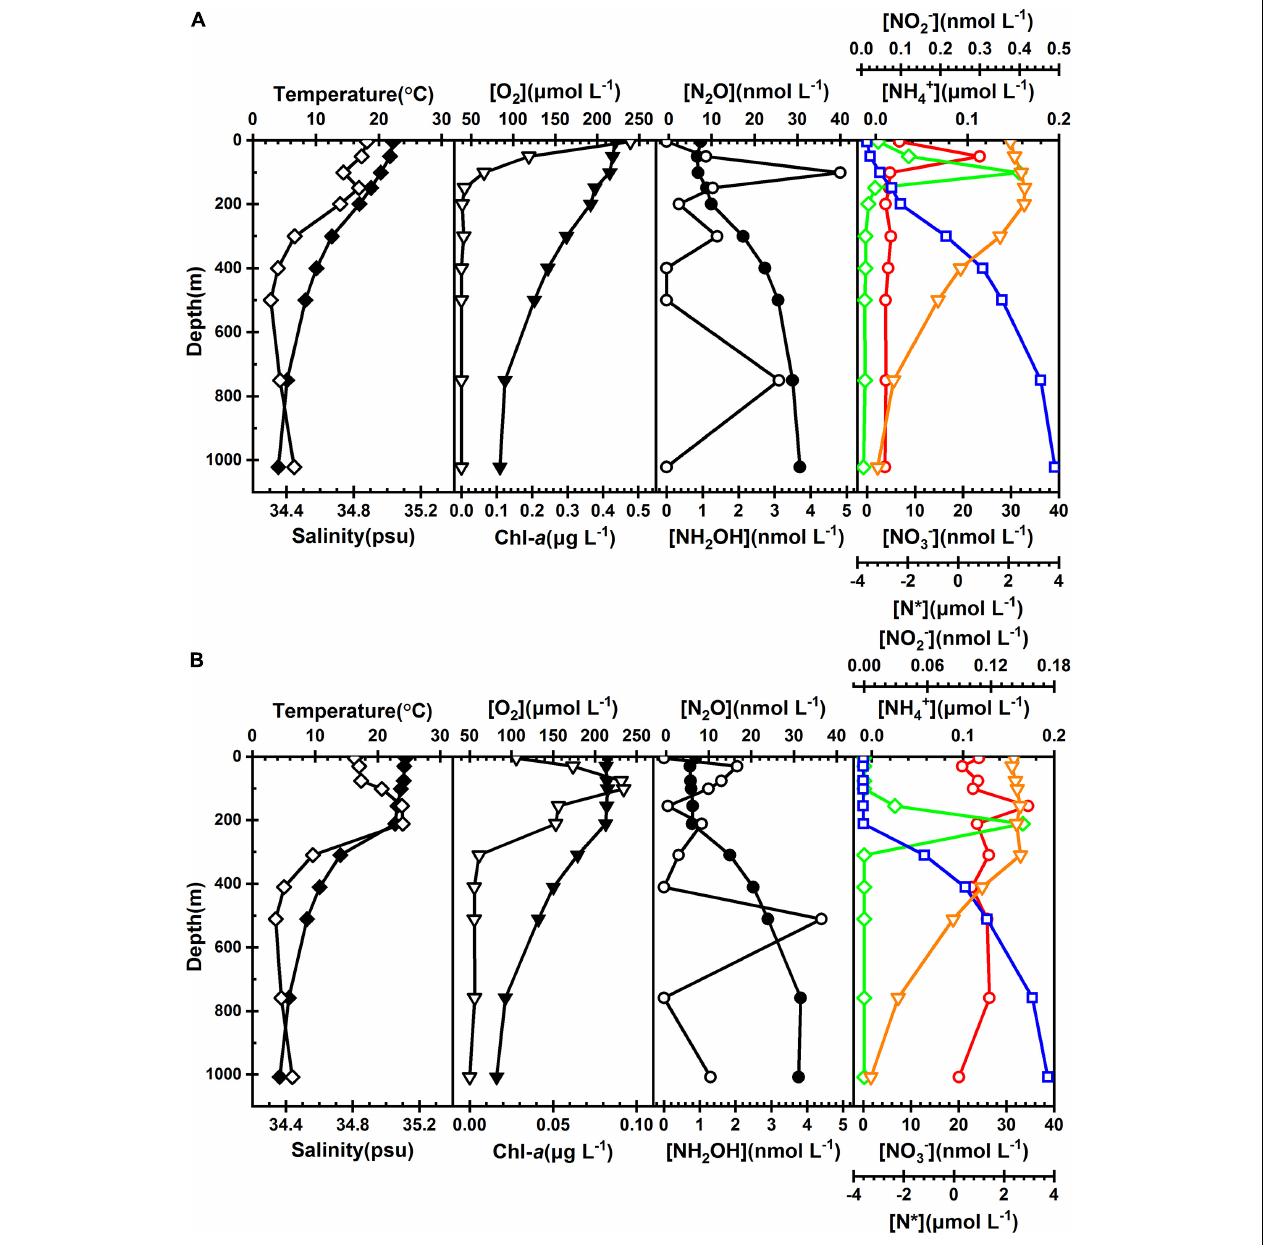
FIGURE 7 | The vertical profiles of temperature ( ◦ C, solid diamond), salinity (psu, open diamond), O 2 ( µ mol L − 1 , solid triangle), chlorophyll- a ( µ g L − 1 , open triangle),